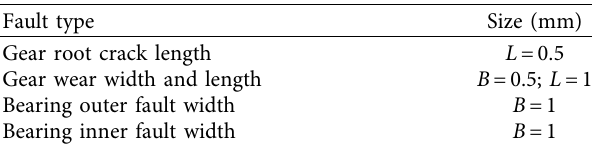
Table 3: Parameters of the